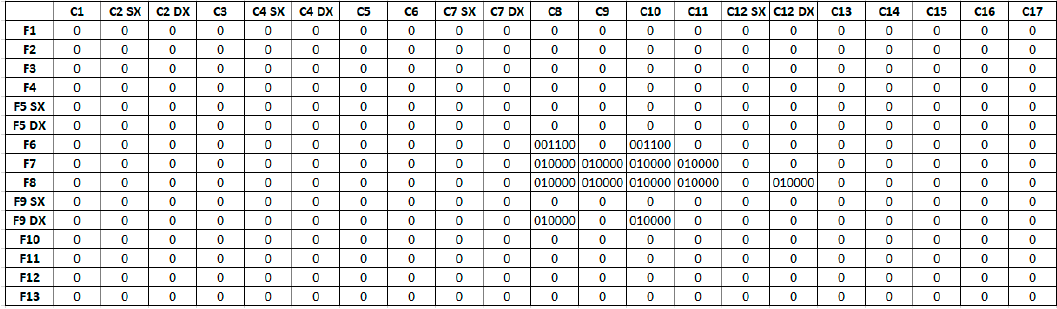
Figure 16. FCM (fasteners components matrix). Machines 2019 , 7 , 29